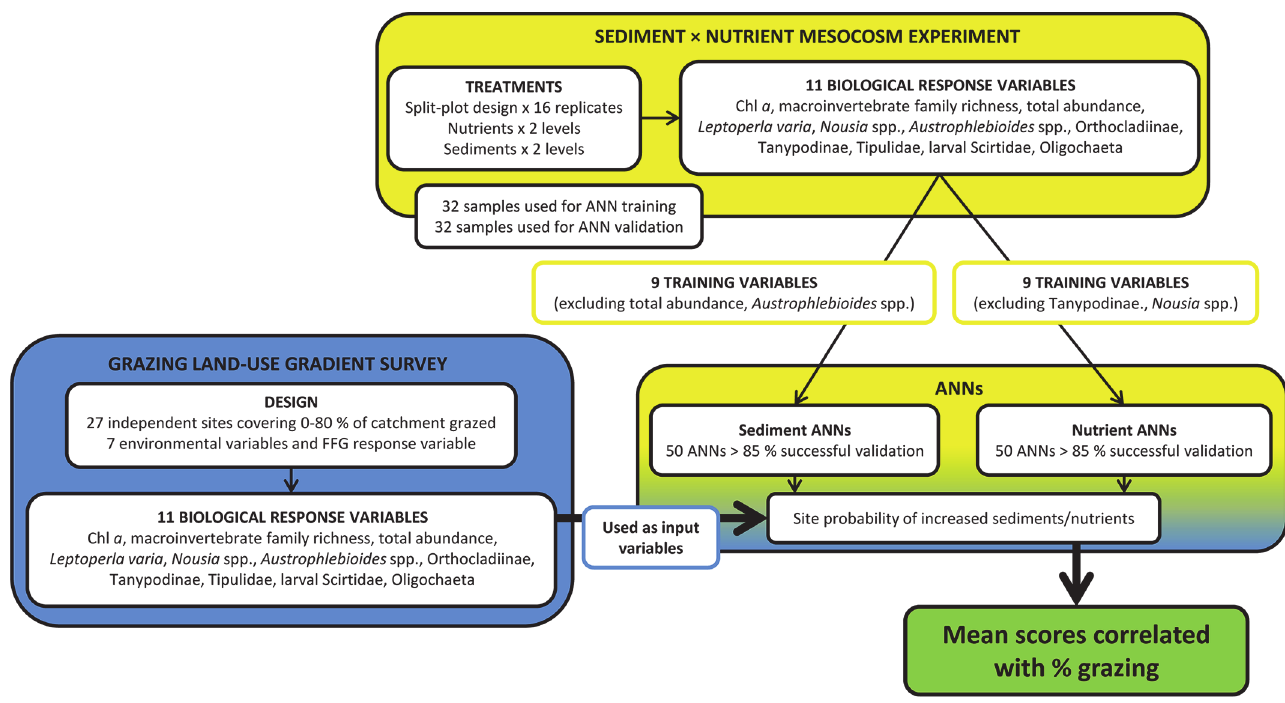
Fig 2. Data flow between gradient survey, mesocosm experiment and artificial neural networks (ANNs). Sites were sampled across a gradient of grazing intensity, expressed as the area proportion of the catchment used for grazing livestock. The sediment and nutrient ANNs were constructed and trained on response variables from a mesocosm experiment run at varying sediment and nutrient levels, with half these data held back for ANN validation. The validated ANNs were then used to generate probabilities of site sediment and nutrient status based on the site biological response variables measured in the gradient